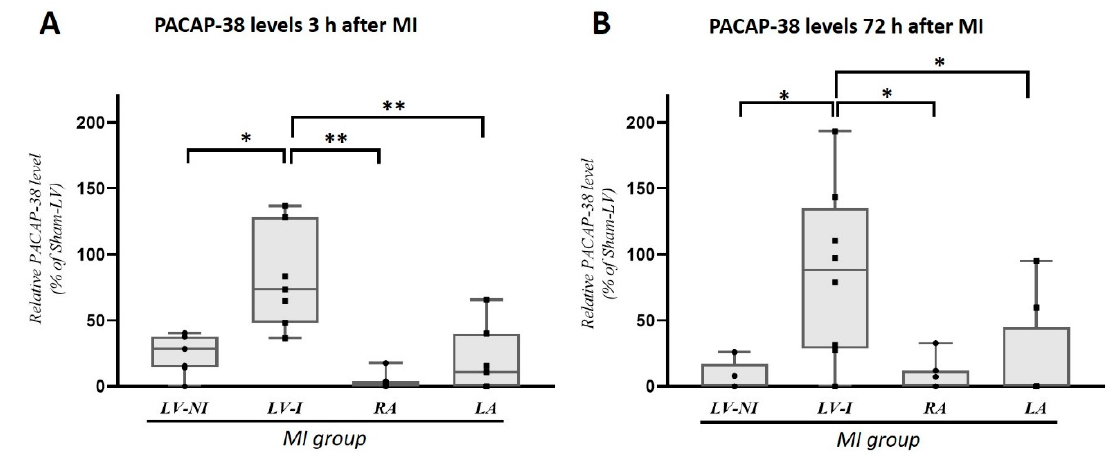
Figure 3. Comparison of the tissue PACAP-38 levels between different heart chambers and regions 3 h ( A ) or 72 h ( B ) after myocardial infarction (MI). PACAP-38 level was decreased in the non-ischemic region of the left ventricle (LV-NI) compared to the left ventricle ischemic region (LV-I) at 3 h after myocardial infarction ( A ). Significantly lower PACAP-38 levels were detected both in right atrium (RA) and left atrium (LA) compared to the ischemic LV region. Similar expression pattern was detected 72 h after myocardial infarction ( B ). The boxes show the interquartile ranges, and the whiskers indicate the most extreme observations. The middle line within the boxes represents the median values. Individual values are presented as black dots and squares. One-way ANOVA with Tukey post-hoc, * p < 0.05, ** p < 0.001 versus LV-I groups. n = 7–8.